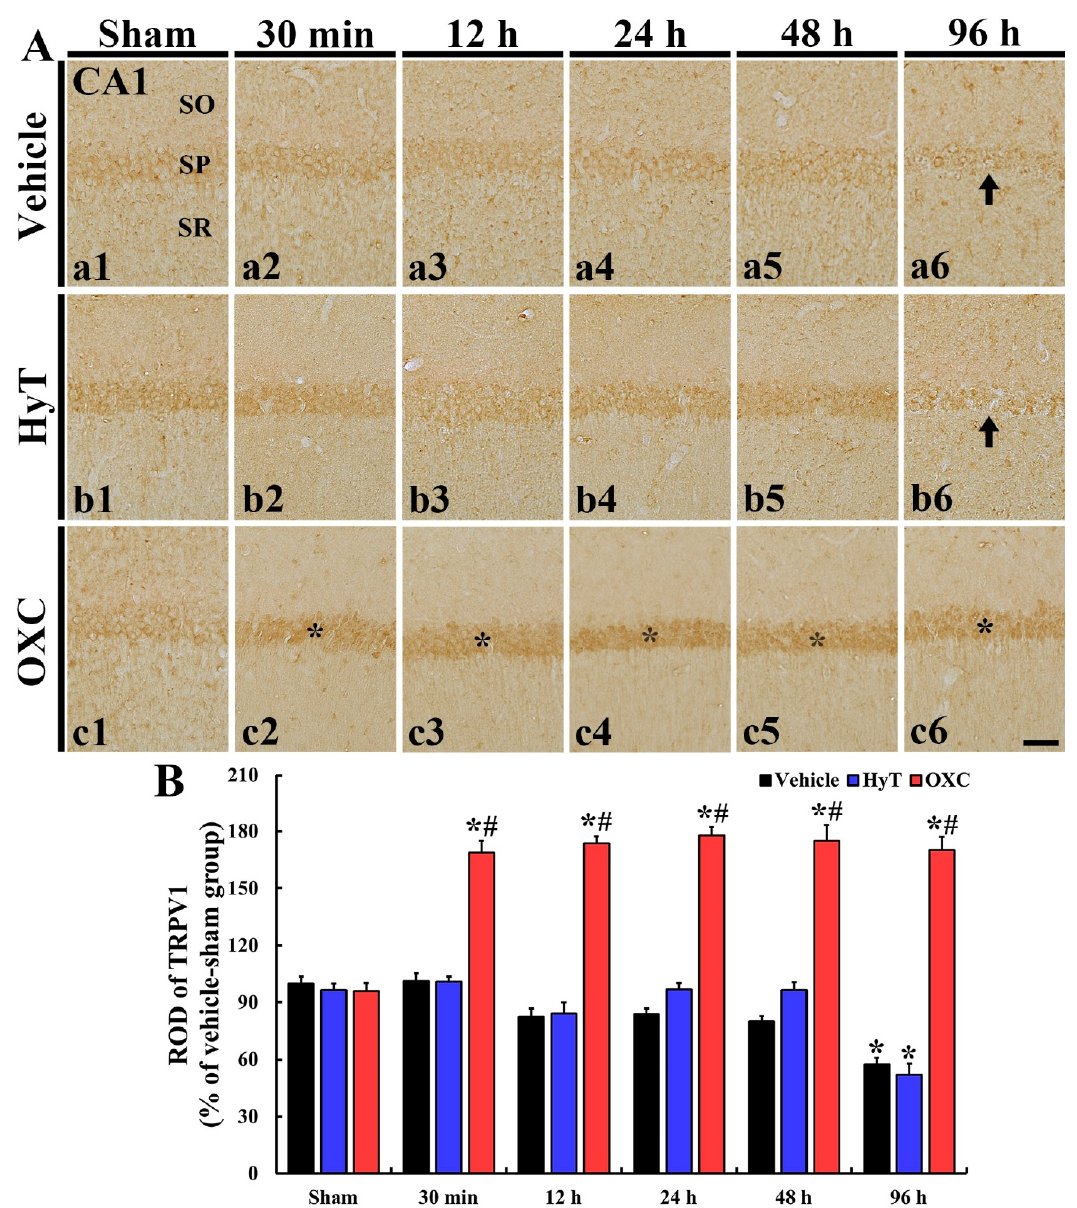
Figure 5. ( A ) Representative images of TRPV 1 immunohistochemistry in the CA1 region of all groups at 30 min, 12 h, 24 h, 48 h, and 96 h after tFI or sham operation. In the tFI+vehicle and tFI+HyT groups, TRPV1 immunoreactivity was not significantly changed in the stratum pyramidale (SP) until 48 h after tFI, but it was markedly reduced (arrows) at 96 h after tFI. In the tFI+OXC group, however, TRPV1 immunoreactivity was significantly increased in the SP at 30 min and maintained (asterisks) until 96 h after tFI. ( B ) Relative optical density (ROD) of TRPV1 immunoreactivity. The bars indicate the means ± SEM ( n = 7 for each group; * p < 0.05 vs. sham+vehicle group, # p < 0.05 vs. corresponding time of the tFI+vehicle group). SO, stratum oriens; SR, stratum radiatum. Scale bars = 100 μ m.